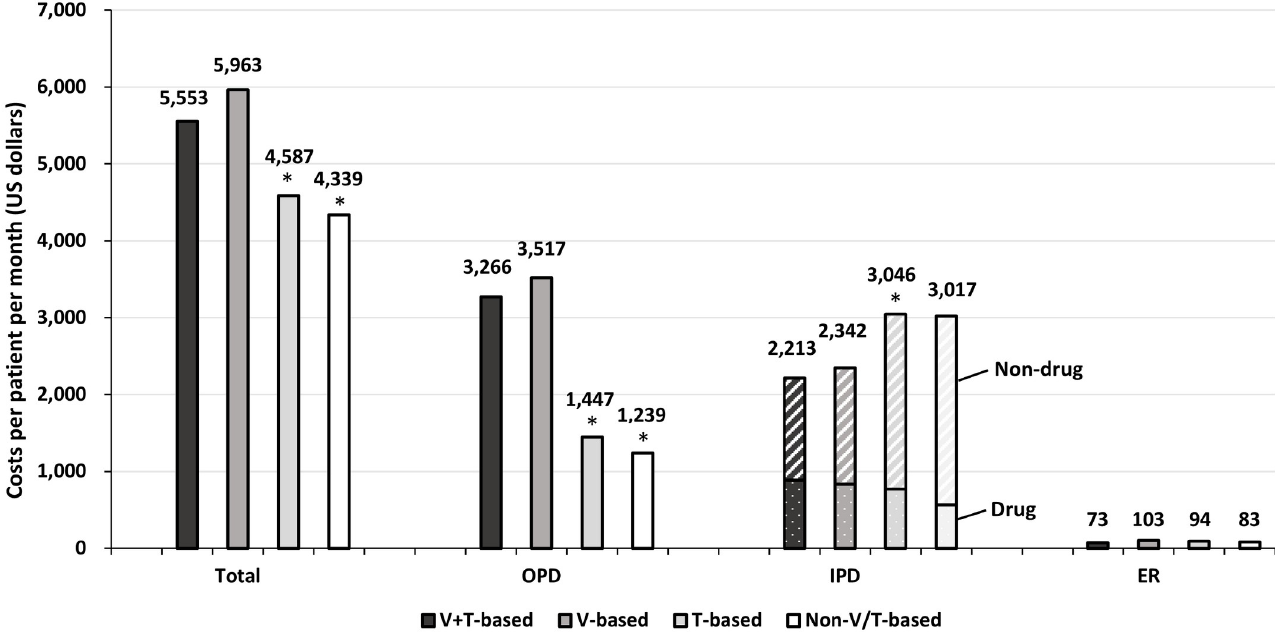
Fig 3. Average cost (per patient per month) within one year after commencement of the 1LOT. The asterisk ( � ) represents that the cost ratio (compared with the V+T-based group) achieved a significant difference. The bar with white slanted lines represents the IPD non-drug-related costs, and the bar with white dots represents the IPD drug-related costs. ER = emergency room; IPD = hospitalizations; OPD = outpatient.